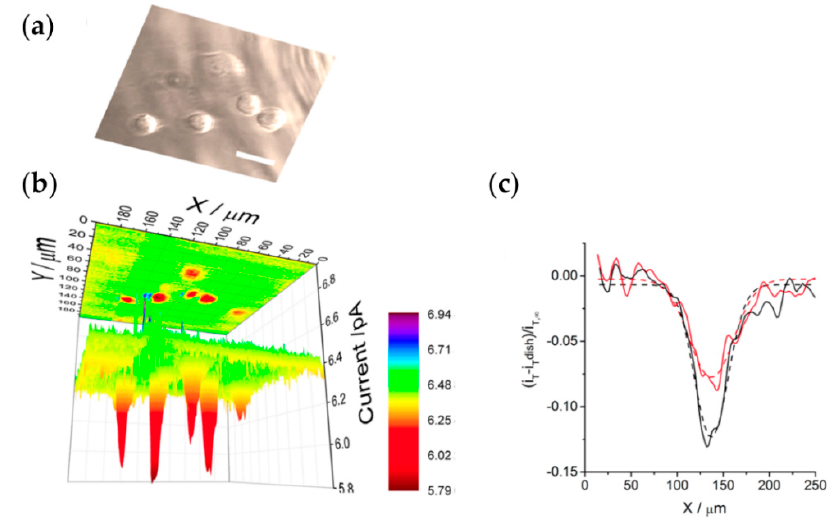
Figure 6. Imaging of glucose uptake by live cells using an enzyme-modified probe in SECM. ( a ) Optical microscope image of the scanned area covering several MCF10A cells. Scale bar is 30 µm. ( b ) Constant height SECM image of glucose uptake of the MCF10A cells, using electropolymerized 10 µm Pt GOx-UME biosensor. ( c ) Single line scans of the normalized current (to steady-state bulk current, i T, ∞ ) of the biosensor probe over a single cell, where the measured tip current, i T , is subtracted by the normalized currents on the Petri dish, i Tdish . Black lines represent the convoluted activity and the topography contributions of the current and red lines represent only the topographical contribution. (Adapted with permission from Reference [87]. Copyright (2017) American Chemical Society).